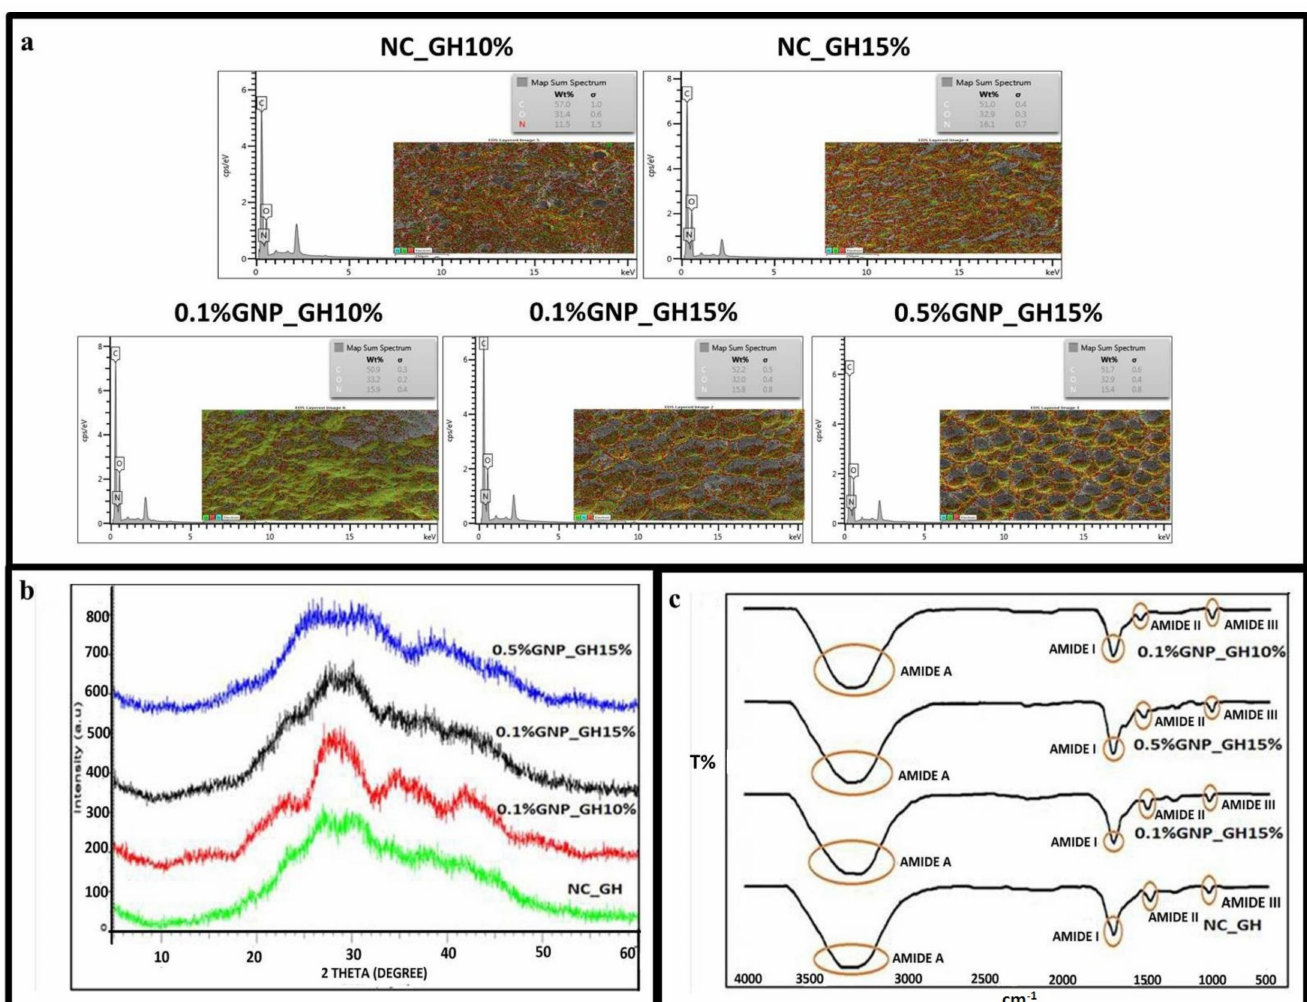
Figure 5. Chemical characterisation. ( a ) EDX map and spectra gave information that the presence of the element in the surface of GNP_GH was similar to NC_GH. ( b ) X-ray diffractogram and ( c ) FTIR spectra confirmed that GNP modification did not alter the origin functional groups and amorphous nature of